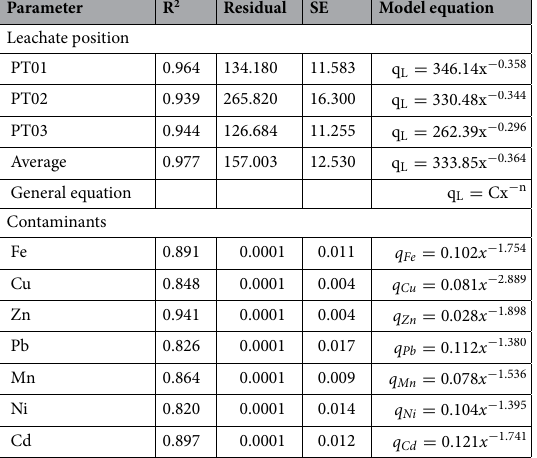
Table 5. Regression of observed and estimated leachate flux and contaminants. NB: SE is the Standard error of the estimate; R 2 is the coefficient of determination; q L is the leachate flux; C is the transmissivity coefficient; x is the thickness of the soil; n is the nonlinear